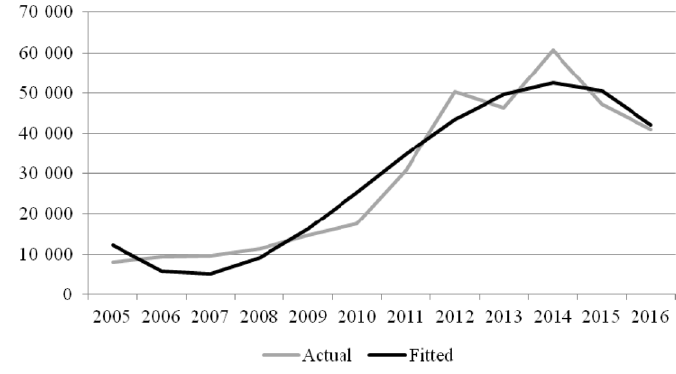
Figure 2. Actual and fitted values of the number of bankruptcy of enterprises in Hungary obtained on the basis of the trend models (source: Own